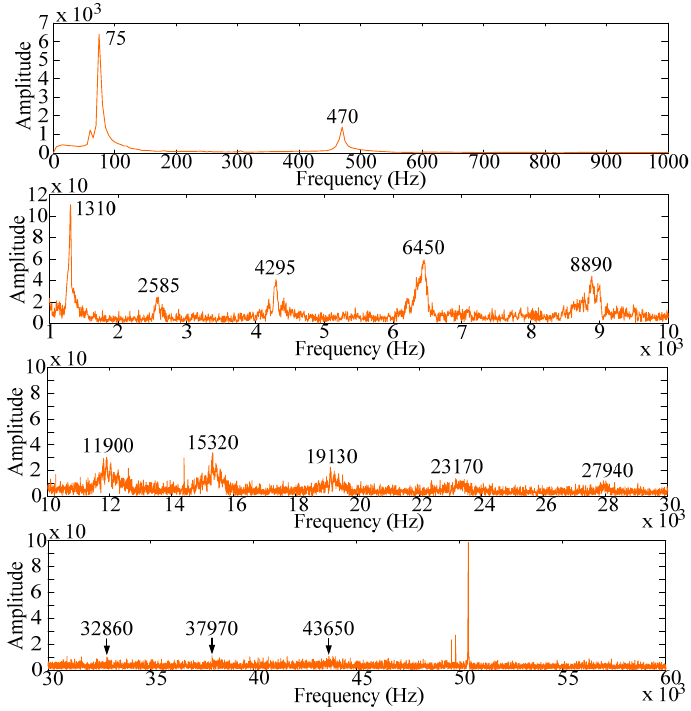
Figure 16. Frequency spectrum of PVDF 2 × 1 with impact on location A.